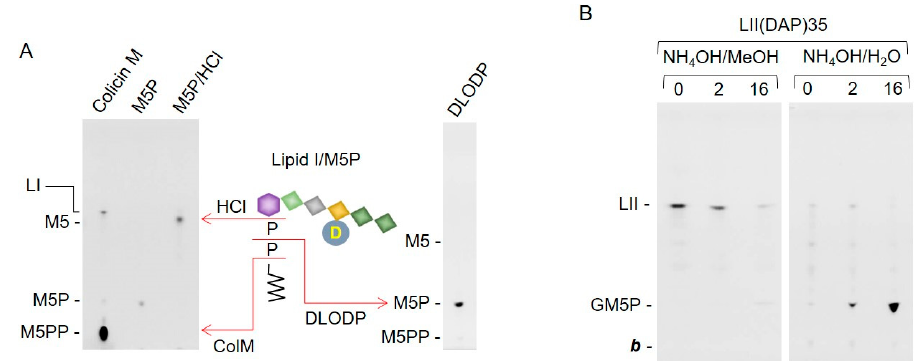
Figure 7. Lipid I and a short-chain LII analog are also hydrolyzed by rat liver microsomal protein. ( A ) LI (500 pmol) was digested with colicin M as described in Section 4, and 100 pmol MurNAc(pentapeptide)-P was treated (M5P/HCl), or not (M5P), with 20 mM HCl for 45 min at 100 °C. After SPE extraction, the 15 mM NH 4 OH eluates were dried and analyzed by TLC (left fluorogram). LI (500 pmol) was digested with detergent-solubilized rat liver microsomal proteins (27.2 µg), as described in Section 4, for 16 h. After SPE, the 15 mM NH 4 OH eluates were dried under vacuum and analyzed by TLC (DLODP, right fluorogram). The migration positions of lipid I, MurNAc pentapeptide (M5), MurNAc(pentapeptide)-P (M5P), and MurNAc(pentapeptide)-PP (M5PP) are indicated to the left of the fluorograms. ( B ) The hydrolysis of LII(DAP)35 (500 pmol) was examined as described for LII(DAP)55 in the legend to Figure 4.